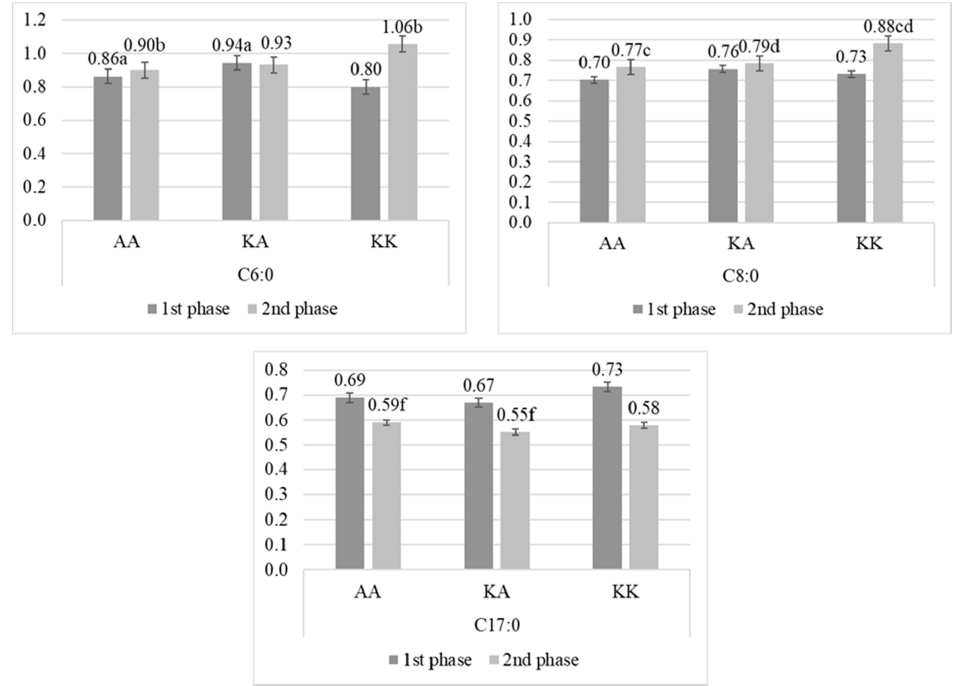
Figure 5. Percentage (mean ± SE) of C6:0, C8:0, and C17:0 fatty acids in milk from Polish Holstein- Frisian cows during first and second phase of lactation depending on K232A single nucleotide polymorphism (SNP) in diglyceride acyltransferase ( DGAT1 ) gene. a, b, c, d—values differ significantly between polymorphisms within fatty acid ( p <